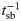
The nucleotide-dependent unbinding rate of a single myosin Ic head from the strongly bound states as a function of force.In (a), we fit the theoretical unbinding rate tsb-1 (Eq 53) (solid lines) to the experimental data (dots) for two different nucleotide concentrations. The orange and blue areas around the experimental data represent the 95% confidence intervals. The parameter values from this fit are summarized in Table 1 and the experimental data have been published [20]. (b) The modeled unbinding rate tsb-1 as a function of force F for different nucleotide concentrations. Although an increased Pi concentration has no effect compared to (a), raising the ADP concentration reduces the unbinding rate. This reduction can be reversed by increasing the ATP concentration.